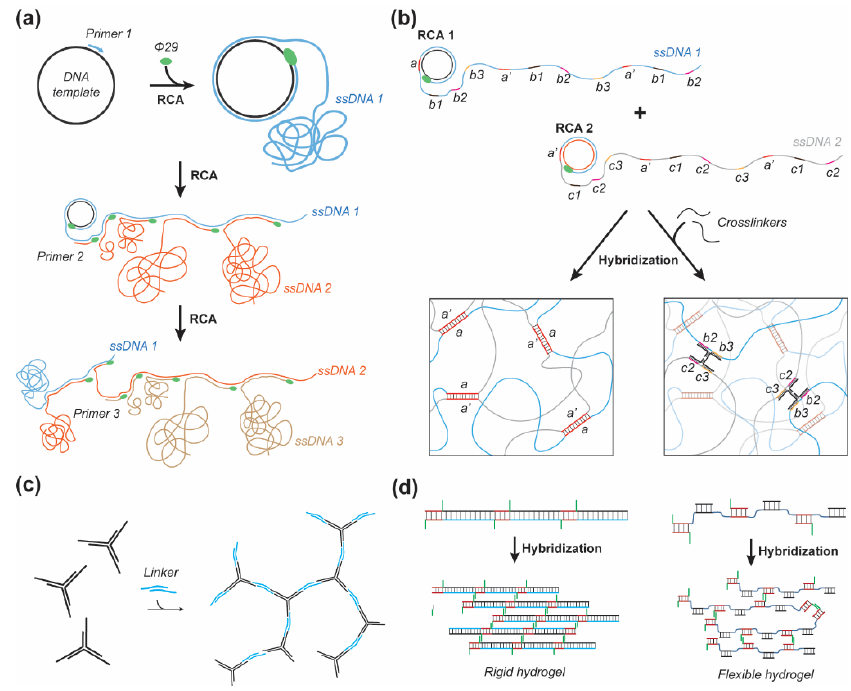
Figure 1. Structural DNA hydrogel design. ( a ) Hydrogel formation by entanglement of RCA-produced concatemeric DNA strands. ( b ) Hydrogel formed by crosslinking of two RCA-produced ssDNA. ( c ) Hydrogels formed by hybridization of multivalent DNA nanostars. ( d ) Hydrogels formed by hybridization of linear sections of dsDNA.